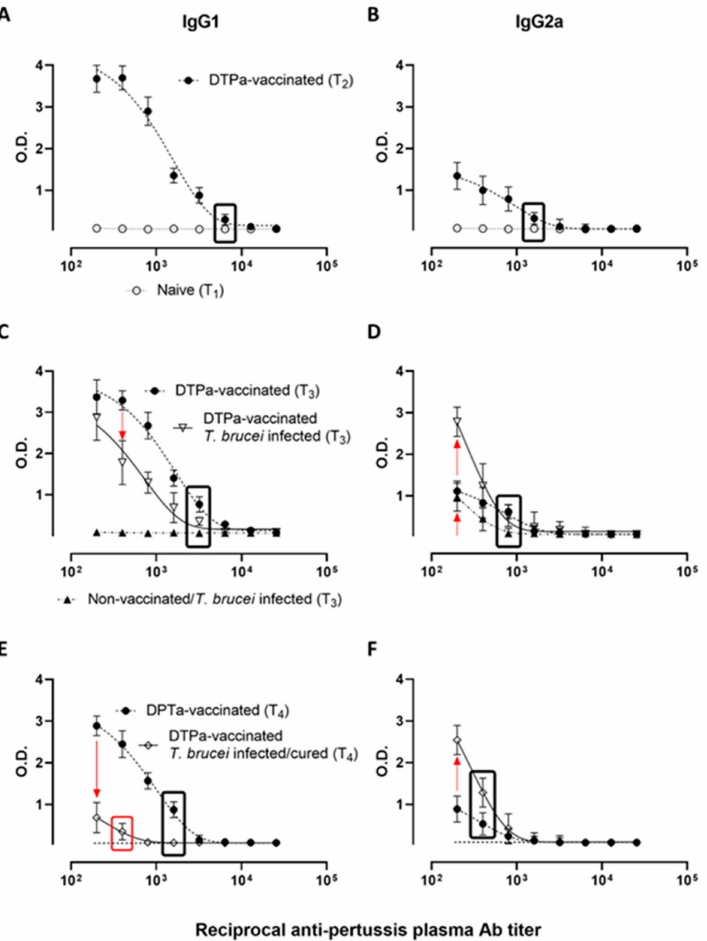
Figure 2. DTPa-induced IgG1 (left panels) and IgG2a (right panels) titers are strongly affected by T. b. brucei infection. ( A , B ) Plasma samples were collected prior to the start of the DTPa vaccination (T 1 ), and two weeks after the vaccine boost (T 2 ). ( C , D ) Plasma samples were collected at experimental timepoint T 3 from both DTPa-vaccinated and non-vaccinated T. b. brucei AnTat 1.1 challenged mice (14 dpi) as well as control DTPa-vaccinated mice that were not infected by T. b. brucei . ( E , F ) Plasma samples were collected at experimental timepoint T 4 from six-week cured DTPa-vaccinated mice that had recovered from their T. b. brucei infection. Control samples were obtained here from DTPa- vaccinated mice that had not been challenged with T. b. brucei . Plasma dilution series (1:2) were made to determine anti- B. pertussis antibody endpoint titers for all experimental groups indicated as black boxed data points. This value represents the last serial dilution resulting in an OD that is significantly different from the OD value obtained at the same dilution in naïve mice (represented in d, e and f as a dashed line). The red boxed value in ( E ) indicates the significant T. b. brucei -induced reduction in IgG1 titers at T 4 . The red arrows indicate the T. b. brucei -induced trends in reduction ( C , E ) or increase ( D , F ) in anti-pertussis antibody ELISA OD readings. Values are represented as the mean ± SD of five individual mice per